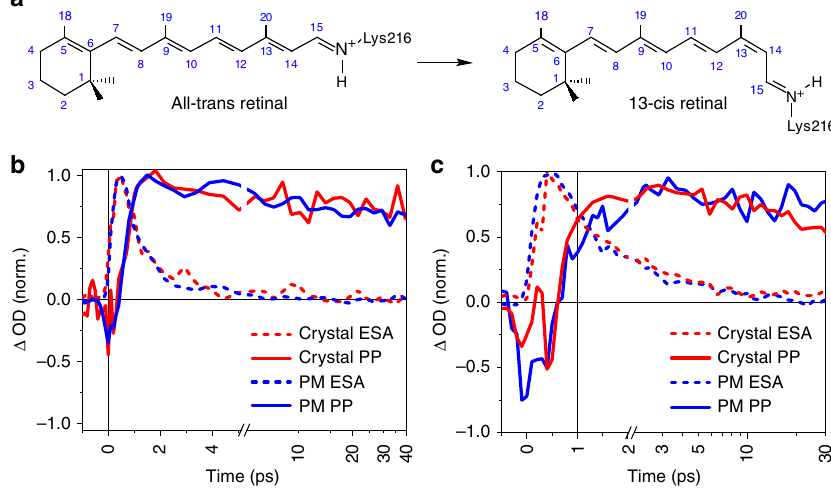
Fig. 1 Retinal isomerization kinetics in purple membrane and bacteriorhodopsin (bR) microcrystals. a Schematic all- trans and 13- cis retinal covalently bound to Lys216 as a protonated Schiff base. b , c Direct comparison of kinetic traces in the ultraviolet/visible region for purple membrane (PM, blue) in H 2 O, pH = 5.6, and the bR microcrystals in lipidic cubic phase (red) as a function of peak intensities, 35 and 88 GW cm − 2 , respectively. Within the present signal- to-noise ratio, the dynamics of 13- cis isomer formation (PP, probe wavelength 670 ± 5nm, solid lines) and excited-state decay (excited-state absorption (ESA), 480 ± 5 nm, dashed) are identical. See Supplementary Fig. 5 for a complete comparison as a function of excitation density. Source data are provided for Fig. 1b, c as a Source Data fi